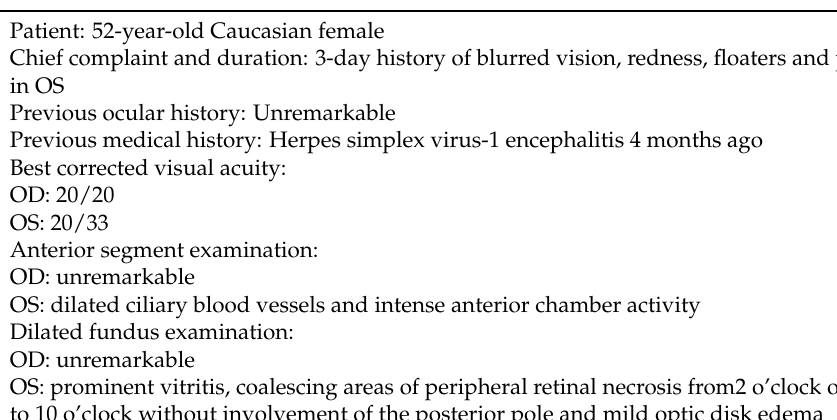
Table 1. Patient’s clinical data.